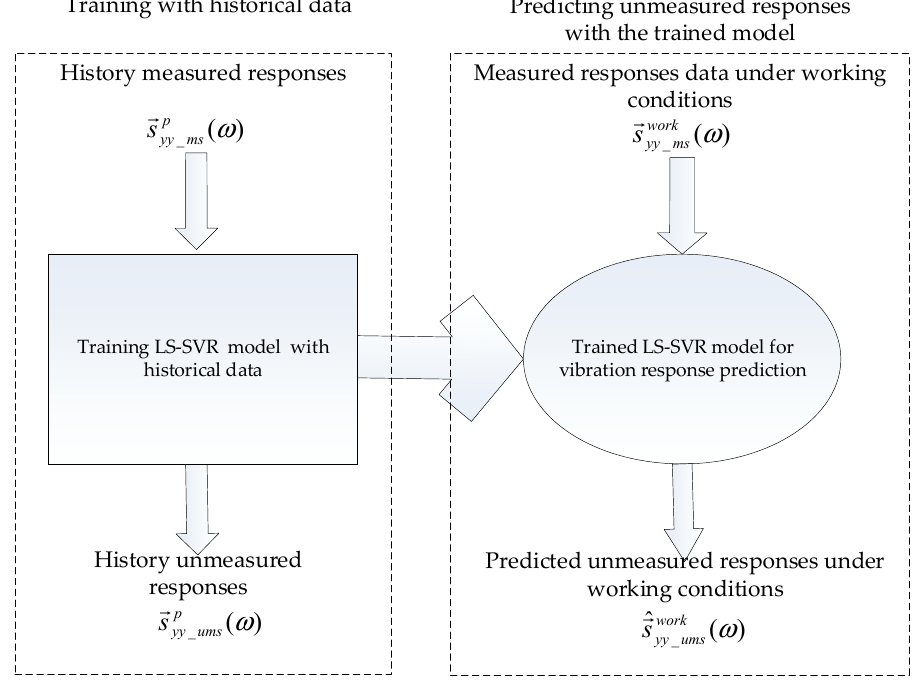
Figure 2. Procedure for building and applying the multi-input multi-output least squares support vector regression (MIMO LS-SVR)-based multi-point vibration response prediction model in the frequency domain under unknown uncorrelated multi-source loads.